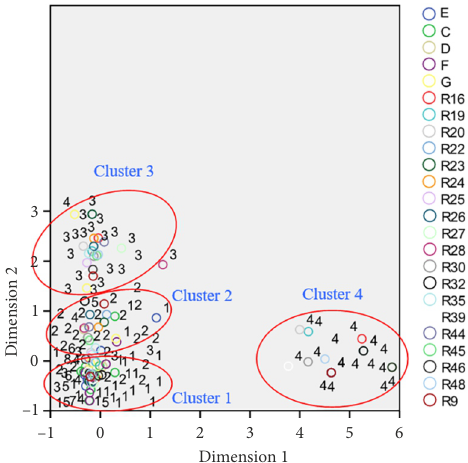
Figure 2. Factorial plane of the quantification the variable catego- ries (Categories of risk-weighting variables that have total mean discriminations greater than 0.5: 1. Low, 2. Medium, 3. High and 4. None or not applicable) and general company variables (see